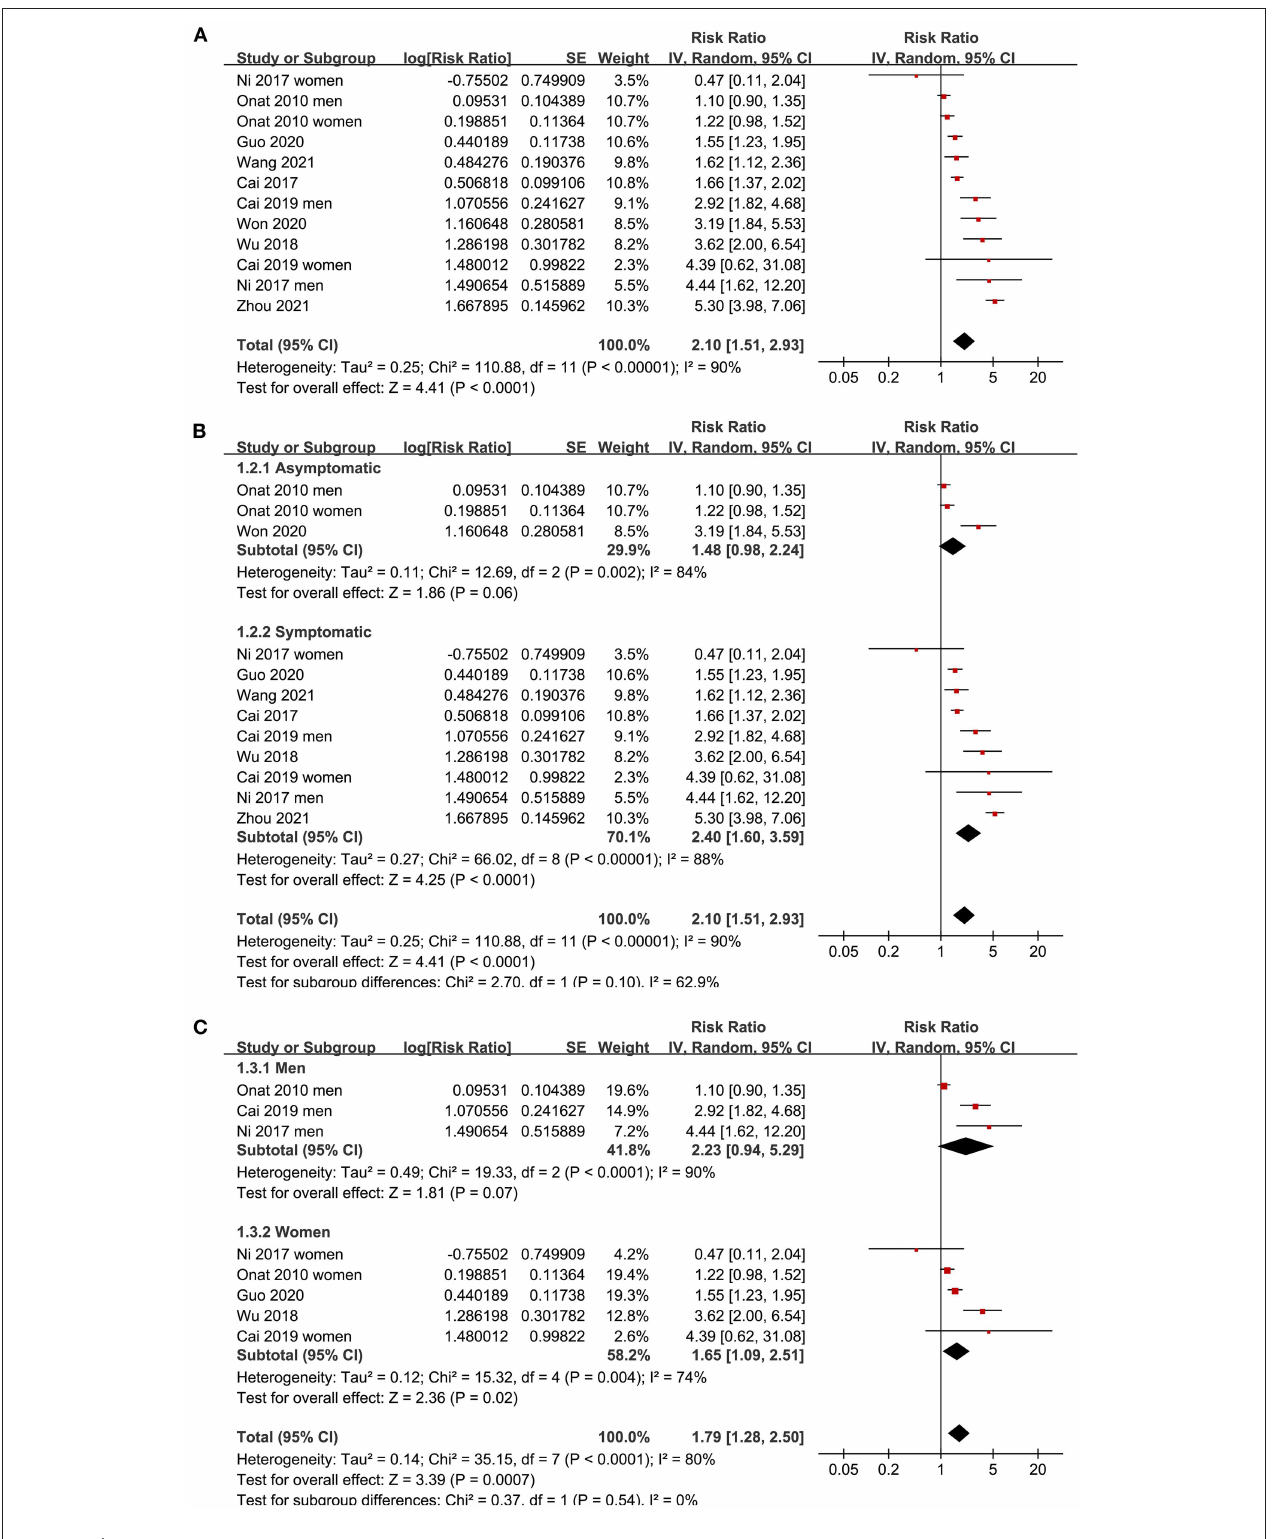
FIGURE 2 | Forest plots for the meta-analysis of the association between the AIP analyzed as a continuous variable and the odds of CAD in the adult population. (A) Overall meta-analysis; (B) Subgroup analysis according to the health status of the participants; and (C) Subgroup analysis according to the sex of the participants.